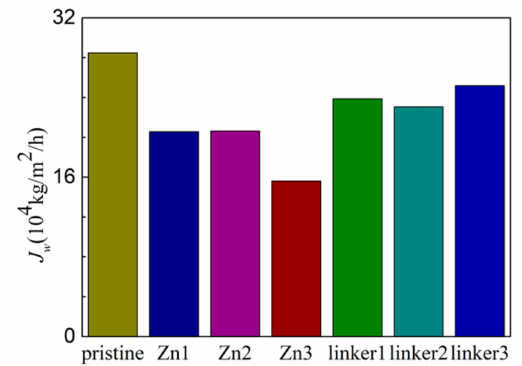
Figure 8. Water flux of the ZIF-8 membranes with different types and concentrations of substitutional defect